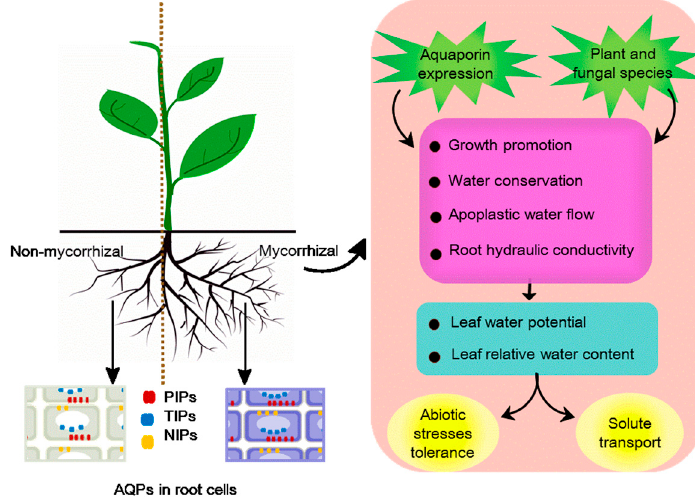
Figure 2. Model of the role of aquaporins (AQPs) in arbuscular mycorrhizae (AM)/ecto-mycorrhizae (EM) symbioses combined with plant–water relations and physiological activity. Mycorrhizal symbioses promote growth of mycorrhizal plants, with a larger root system (the right side of the root system). The amount of AOPs in mycorrhizal plant root cells (right side, blue) is generally more than that in non-mycorrhizal plant root cells (left side, gray). Plasma membrane intrinsic proteins (PIPs) and nodulin 26-like intrinsic proteins (NIPs) are in plasma membranes, and tonoplast intrinsic proteins (TIPs) are in the tonoplast (white oval). The regulation of plant AQPs contributes to growth promotion, water conservation, apoplastic water flow, and root hydraulic conductivity to maintain the relative water content and leaf water potential. Favorable water relation promotes solute transport and increases abiotic stress tolerance. Plant and fungal species could also influence the efficacy of the above resistance mechanism.